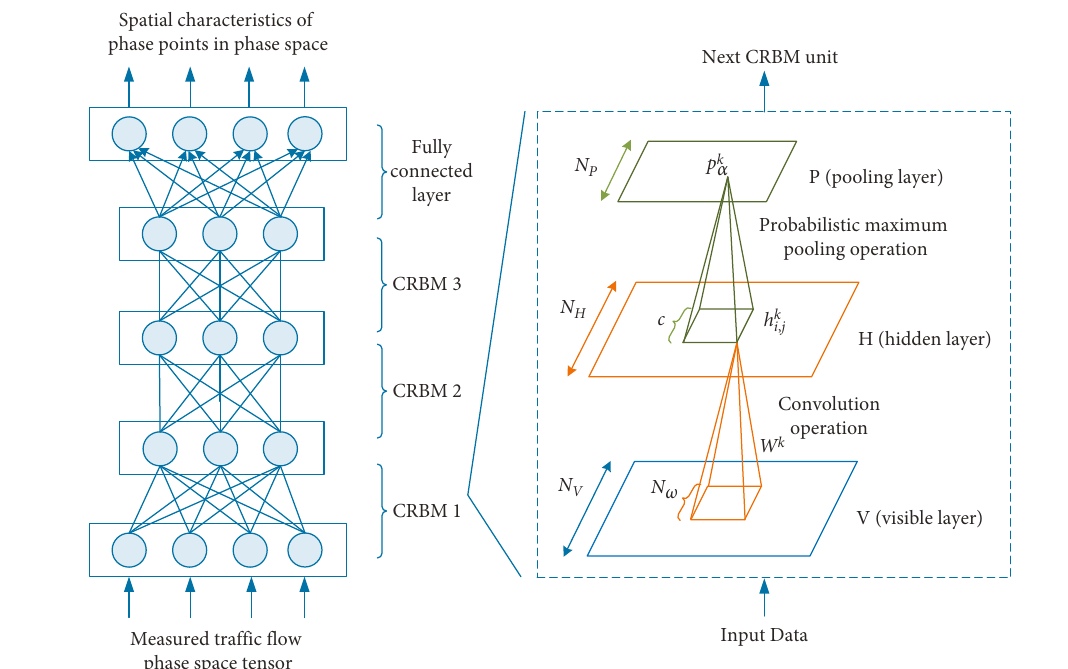
Figure 6: Hierarchy diagram of the CDBN network.